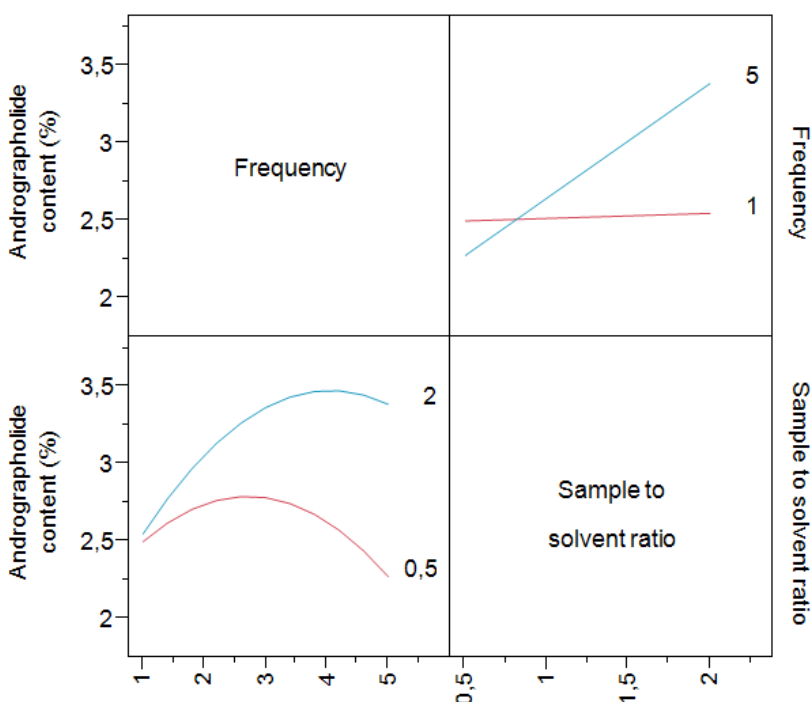
Figure 2. Plot of interactions effects of sample to solvent ratio and frequency to andrographolide content.